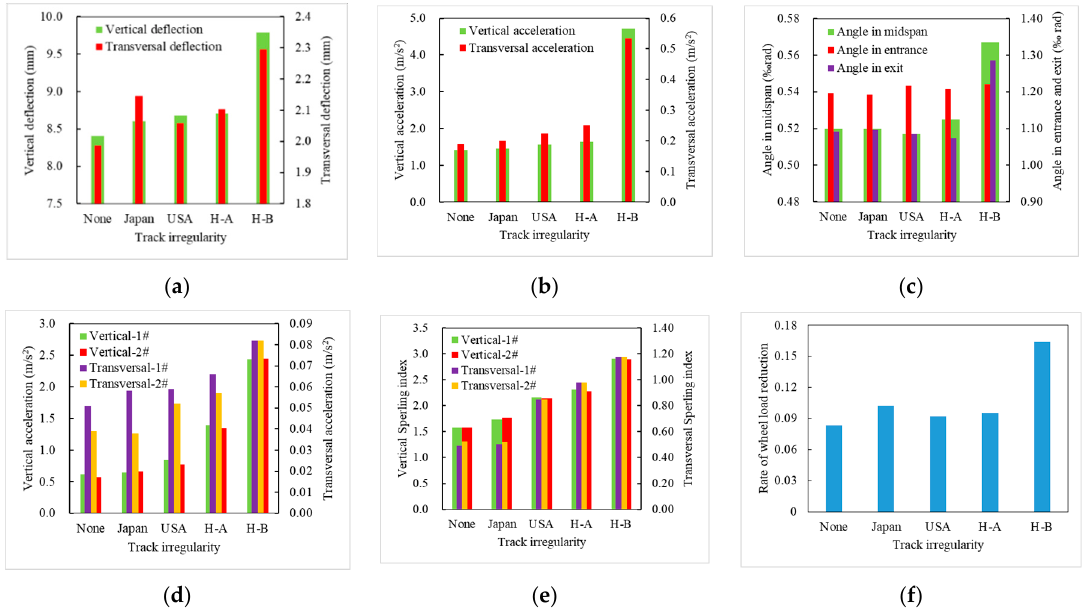
Figure 12. Responses of the bridge and the train considering differences in track irregularity—( a ) bridge deflection, ( b ) bridge acceleration, ( c ) bridge angle, ( d ) train acceleration, ( e ) Sperling index, and ( f ) rate of wheel load reduction.